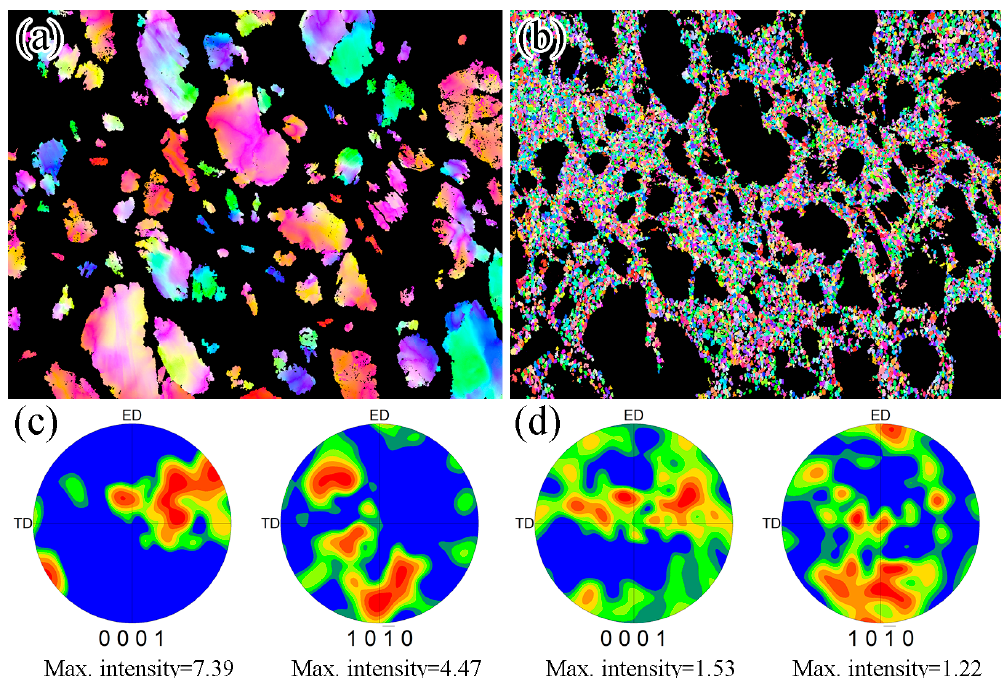
Figure 8. OIM maps and corresponding EBSD-derived pole figures of the edge of the sample #3: ( a , c ) deformed grains; ( b , d ) DRXed grains.